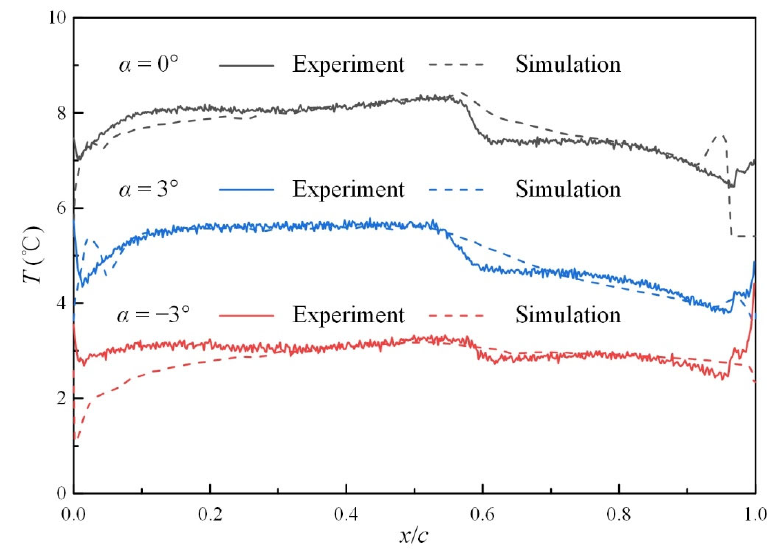
Figure 4. Temperature around RAE5243 airfoil.